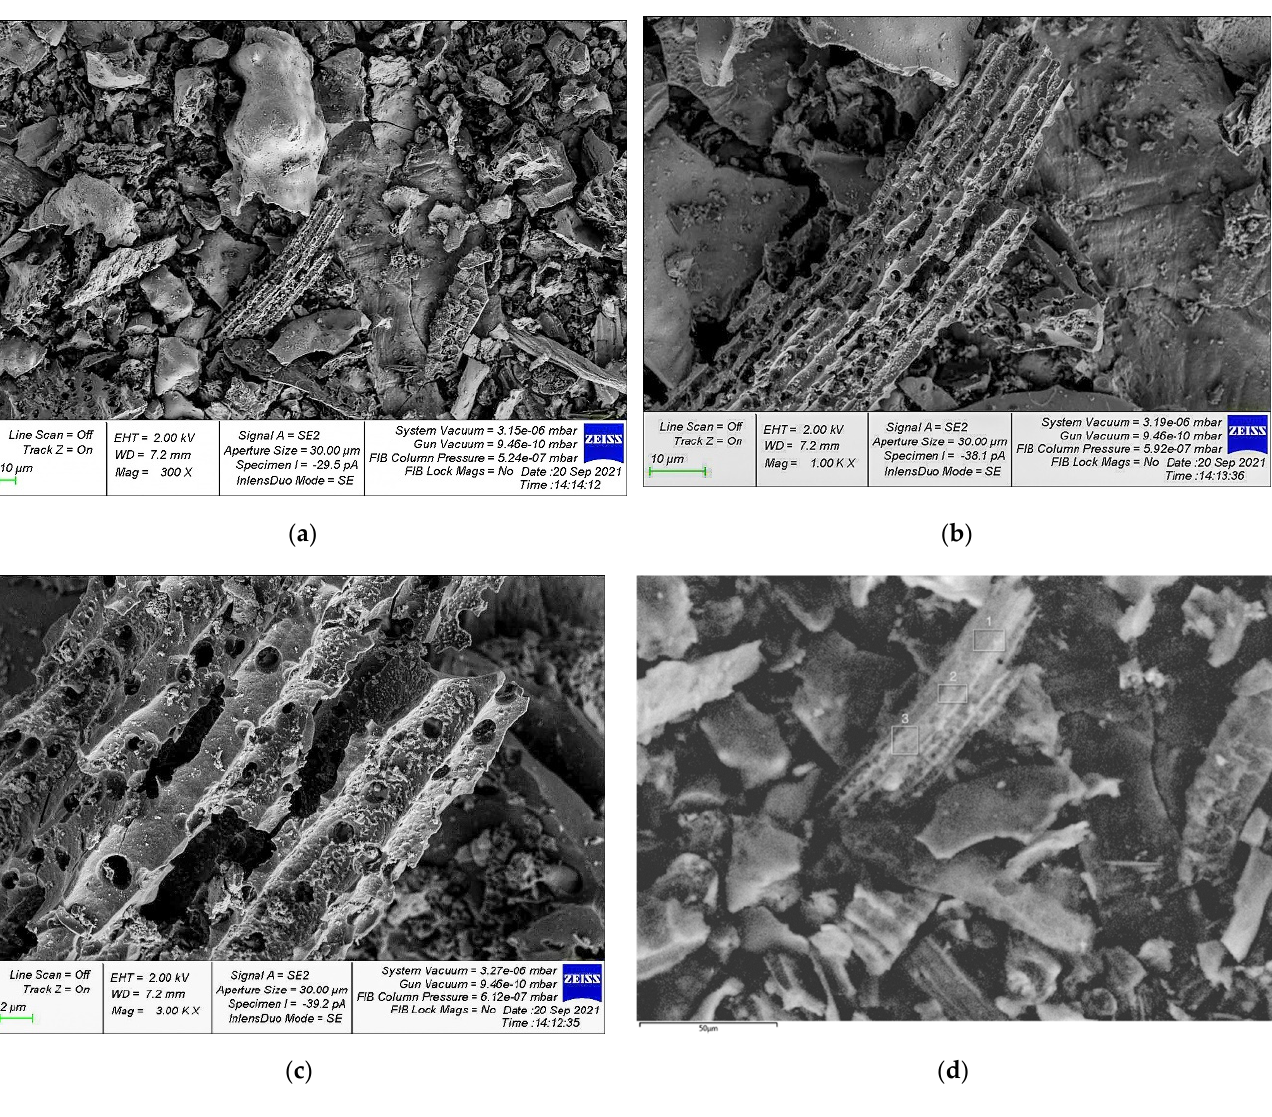
Figure 5. Microstructure photo of rice straw biochar samples: ( a ) with a resolution of 10 nm, ( b ) with a resolution of 3 nm; ( c ) with a resolution of 1 nm; ( d ) regions 1, 2, 3 selected for EDX spectroscopy. A sample of rice straw biochar is a corpuscular porous body, and individual particles of which have ordered cylindrical pores without a bottom of approximately equal